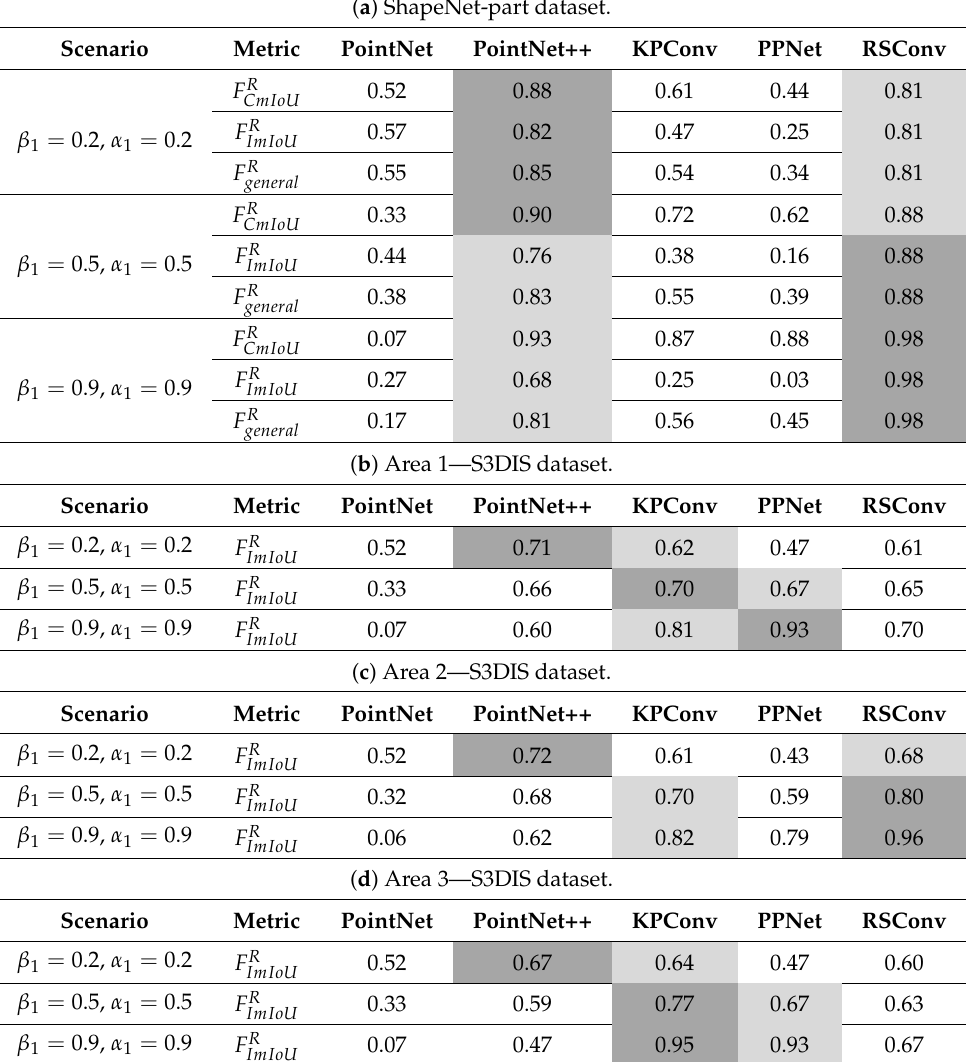
Table 8. Comparison of deep learning models in terms of generalized performance evaluation based on three distinct selections of α 1 , β 1 parameters. Please note that α 1 = 0.2 and β 1 = 0.2 portray an efficiency-biased evaluation, α 1 = 0.5 and β 1 = 0.5 a balanced evaluation between accuracy and efficiency, and α 1 = 0.9 and β 1 = 0.9 an accuracy biased evaluation. Please remind